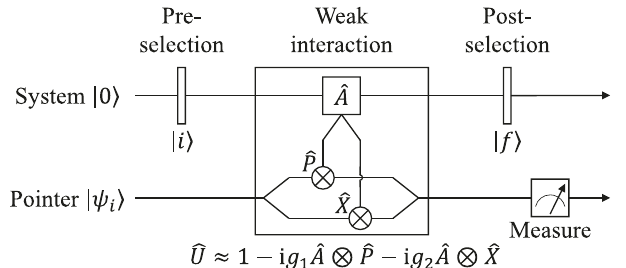
Fig. 3 | Post-selected weak measurement scheme for the incompatible para- meters. Here we investigate the parameters generated by momentum operator ^ P and position operator ^ X during the weak interaction